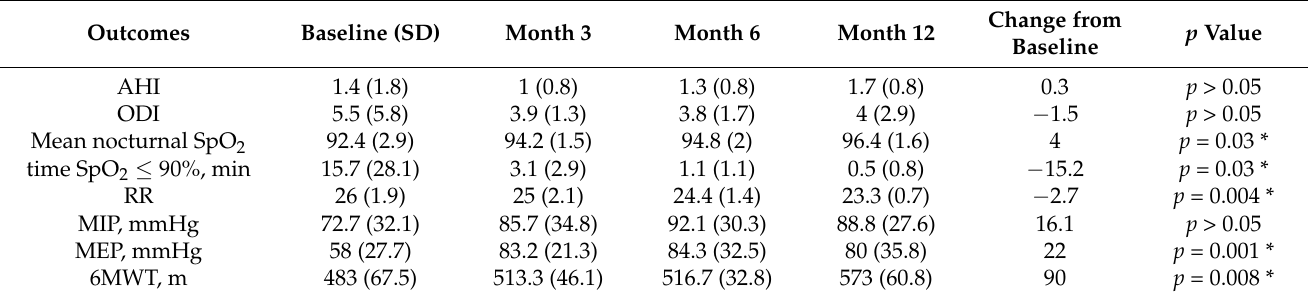
Figure 1. Mean of the absolute change from baseline in cardiorespiratory polygraphy parameters, AHI, ODI, mean SpO 2 , time spent with SpO 2 < 90%, respiratory rate; T03: 3 months, T06: 6 months; T12: 12 months; * p < 0.05. Table 2. Outcome measures at months 3, 6, 12, and mean absolute change from the